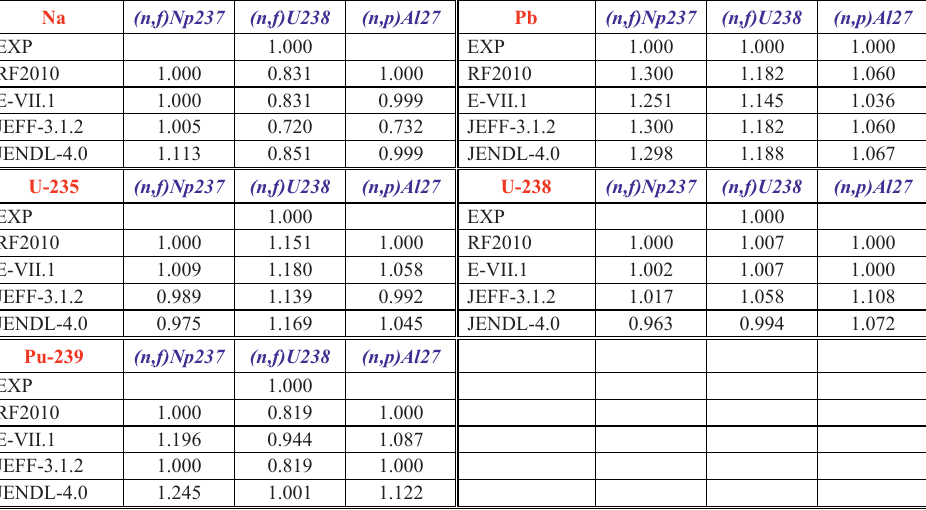
Table 3. The comparison of the removal cross